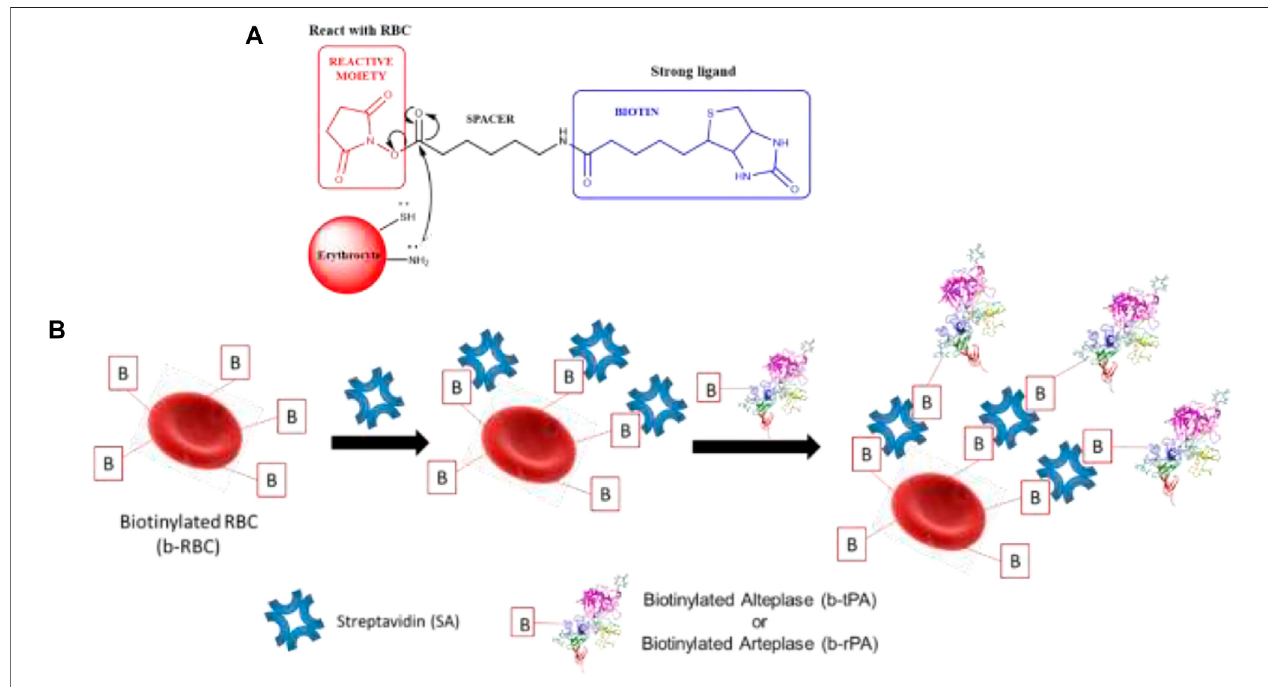
FIGURE 2 | (A) Biotinylation reagents general structure. The reagent shown is NHS-LC-biotin, (B) a streptavidin-biotin technique using RBC as a carrier.